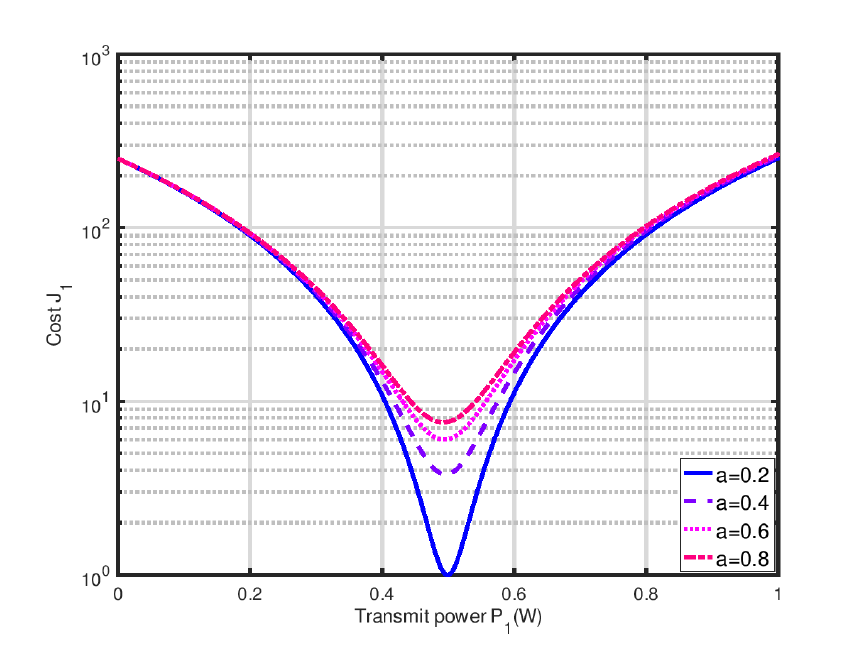
Figure 6. Nash equilibrium of D2D user depends on the sigmoid parameter a .